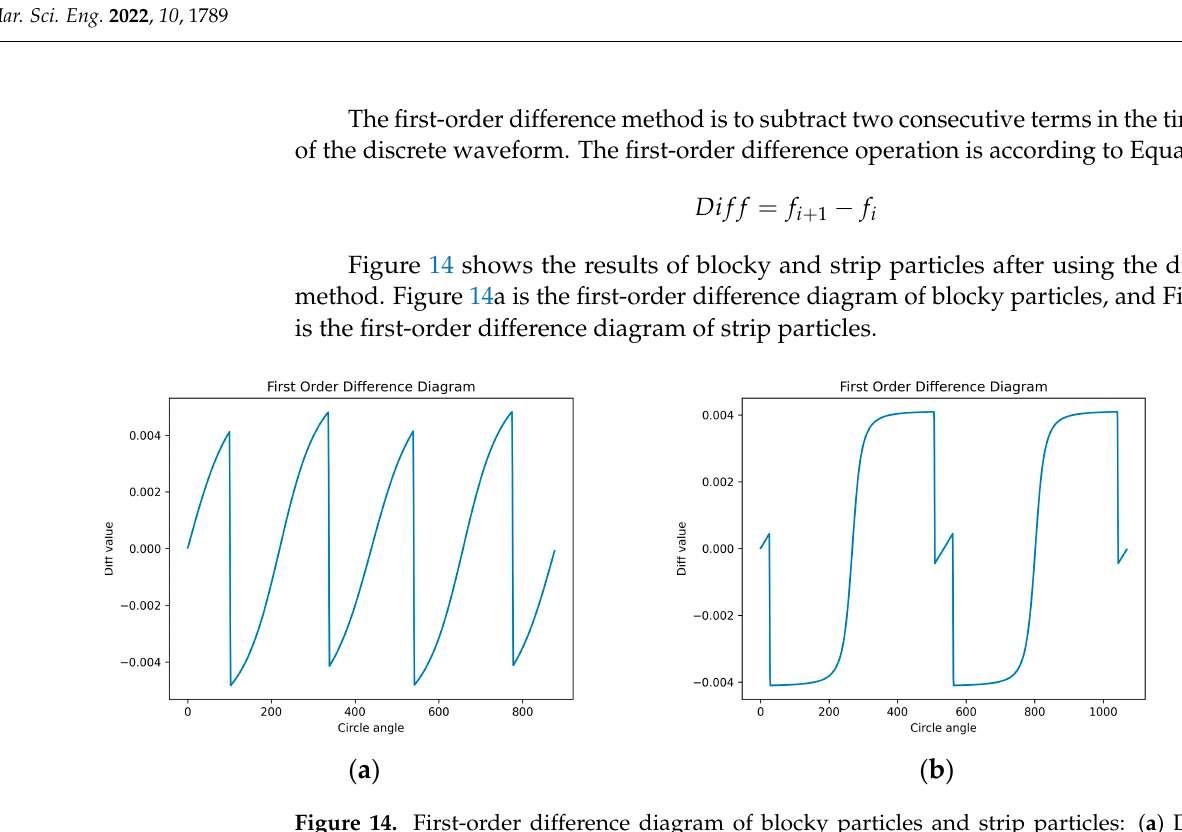
13 of 16 Figure 13. Oil-particle distance-angle waveform: ( a ) Spherical particles waveform; ( b ) Flattened spherical particles waveform; ( c ) Blocky particles waveform; ( d ) Strip particle waveform. According to Figure 13, we can judge whether it is a spherical particle through the periodicity of the sine wave (since there is no perfect circle in nature, it can be considered that if the particle waveform has a large number of corners and is periodic, it can be iden- tified as a spherical particle). The flattening degree is proportional to the fluctuation am- plitude of the signal. The main four unguided points of the blocky particles waveform are sharp and the four corners are periodic, as shown in Figure 13c. In Figure 13d, the four main unguided points of the strip particles waveform are similar to those of the blocky particles wave- form, but the distance between one pair and the other is relatively long. The other particle waveforms can be regarded as irregular particles. We could clearly analyze the waveforms of different particle shapes from the above. 2.4.4. Extracting Characteristic Parameters by Difference Operation Although from Figure 13 we can identify the particle shape of oil particles with our eyes, in order to detect oil particles in real time, an algorithm needs to be designed so that the computer can analyze the waveform. The most important parameters to identify the particle shape is the wave crest and wave trough in the waveform, so this paper used the difference method to extract the characteristic parameters in the waveform. In the continuous domain, the first and second derivatives are generally used to judge the wave peaks and troughs in the waveform graph. The function needs to be fitted in the discrete domain before using the derivative method, but this method has defects.